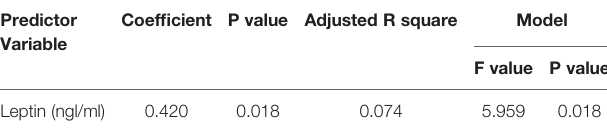
TABLE 6 | Multiple Regression using Stepwise method for VEGF as a dependent variable for Control